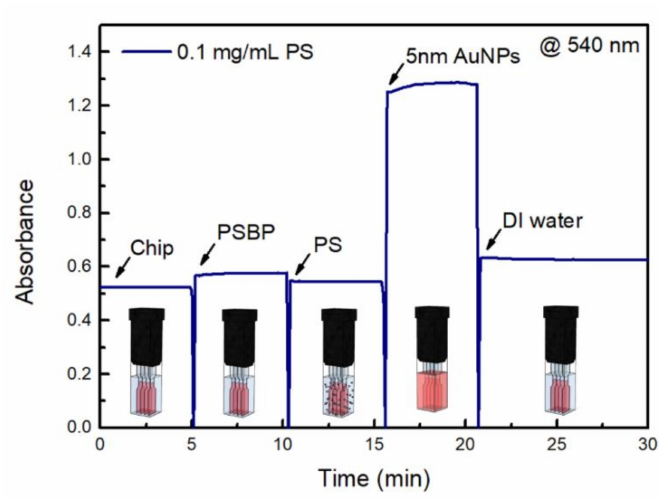
Figure 5. Sensorgram results for sandwich assay UV-Vis spectroscopy-based detection of